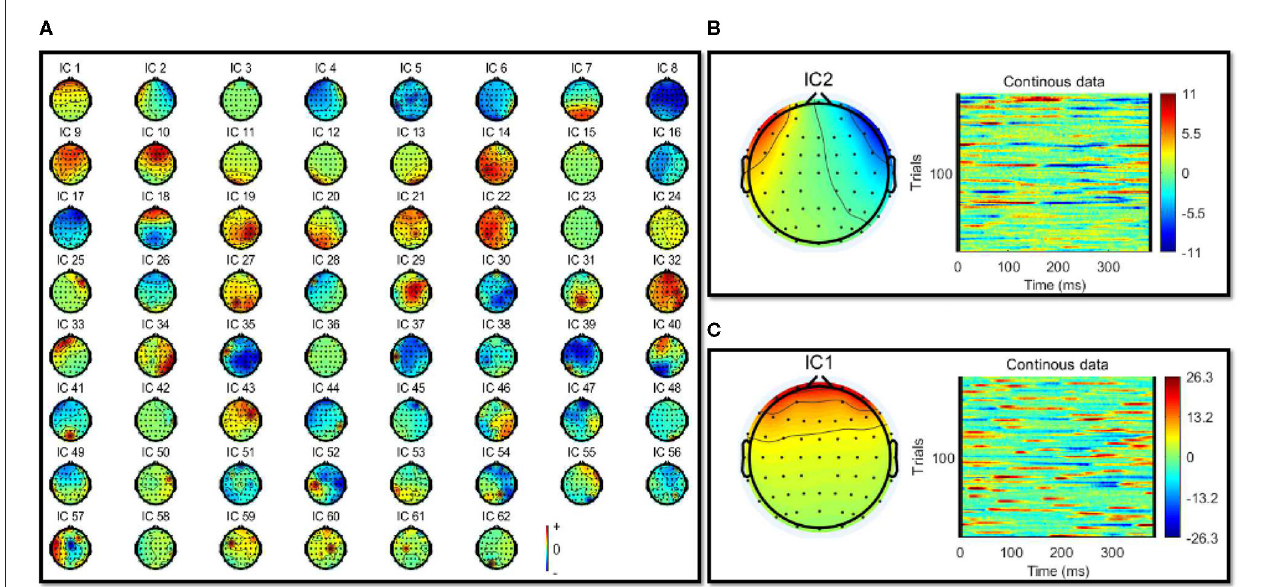
FIGURE 3 | (A) Showed the independent component analysis (ICA) component decomposition result. (B,C) Showed the removed IC components’ topographic map and time-frequency results of removed IC components. (B) Showed the eye blink activity component. (C) Shows the lateral eye movements component.